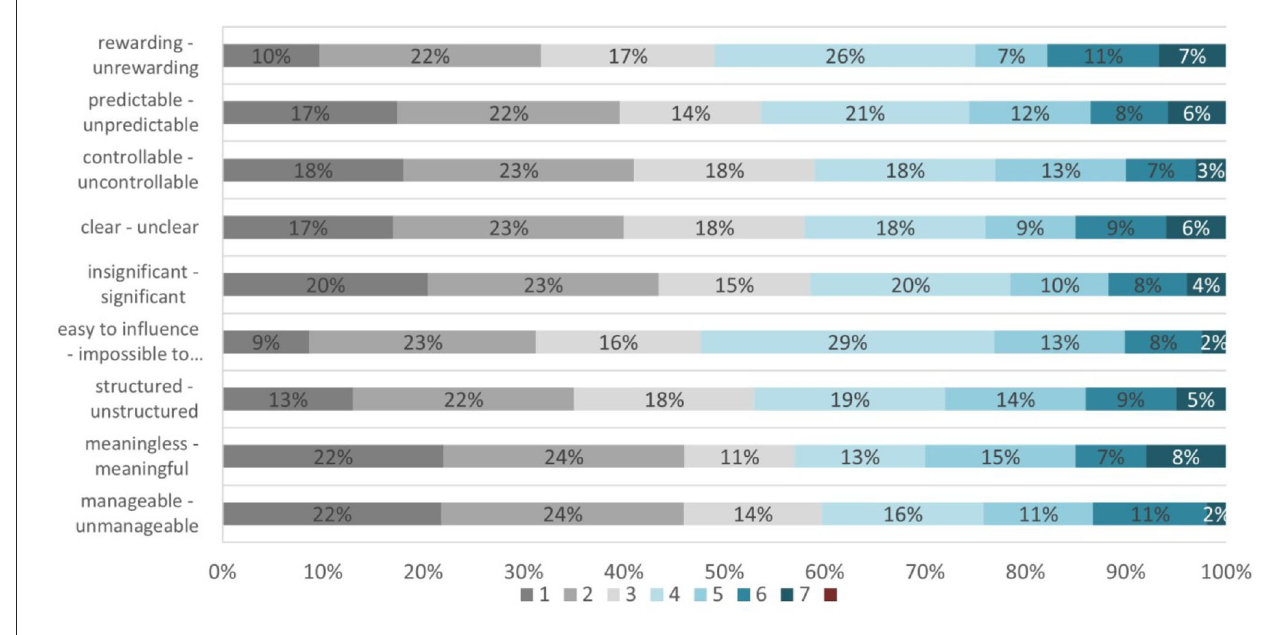
FIGURE7 Students’ wellbeing